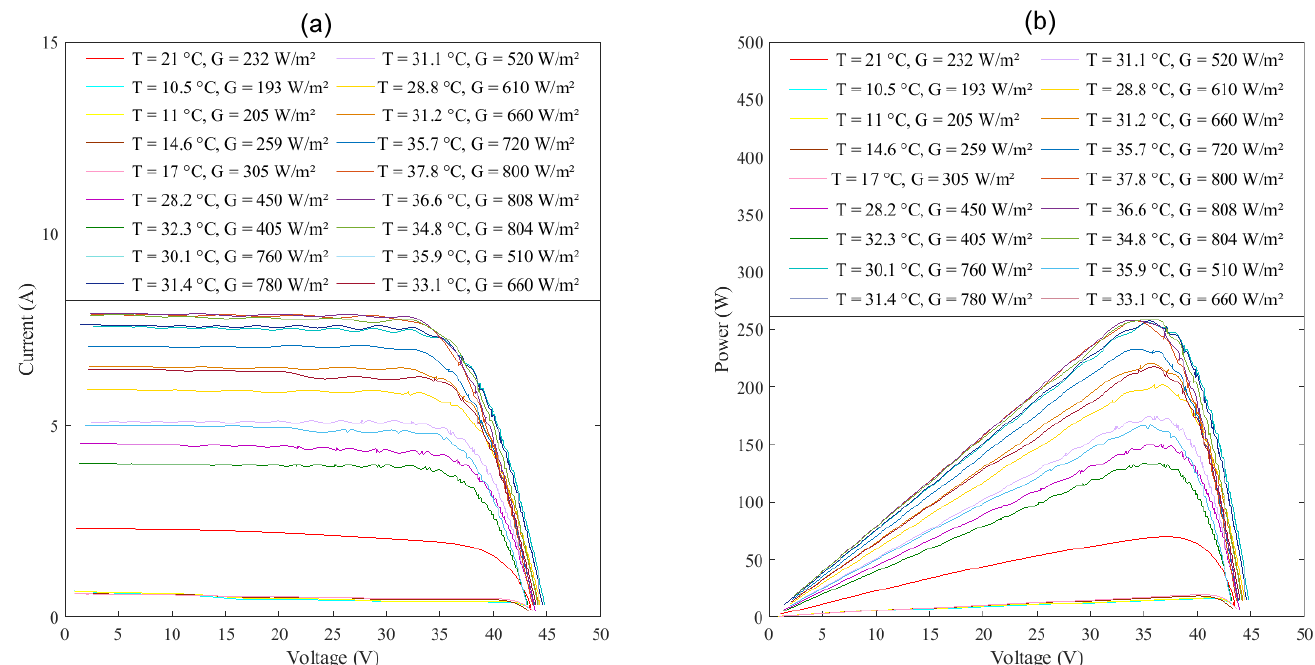
Figure 13. PV panel characteristic curves: ( a ) voltage-current; ( b )